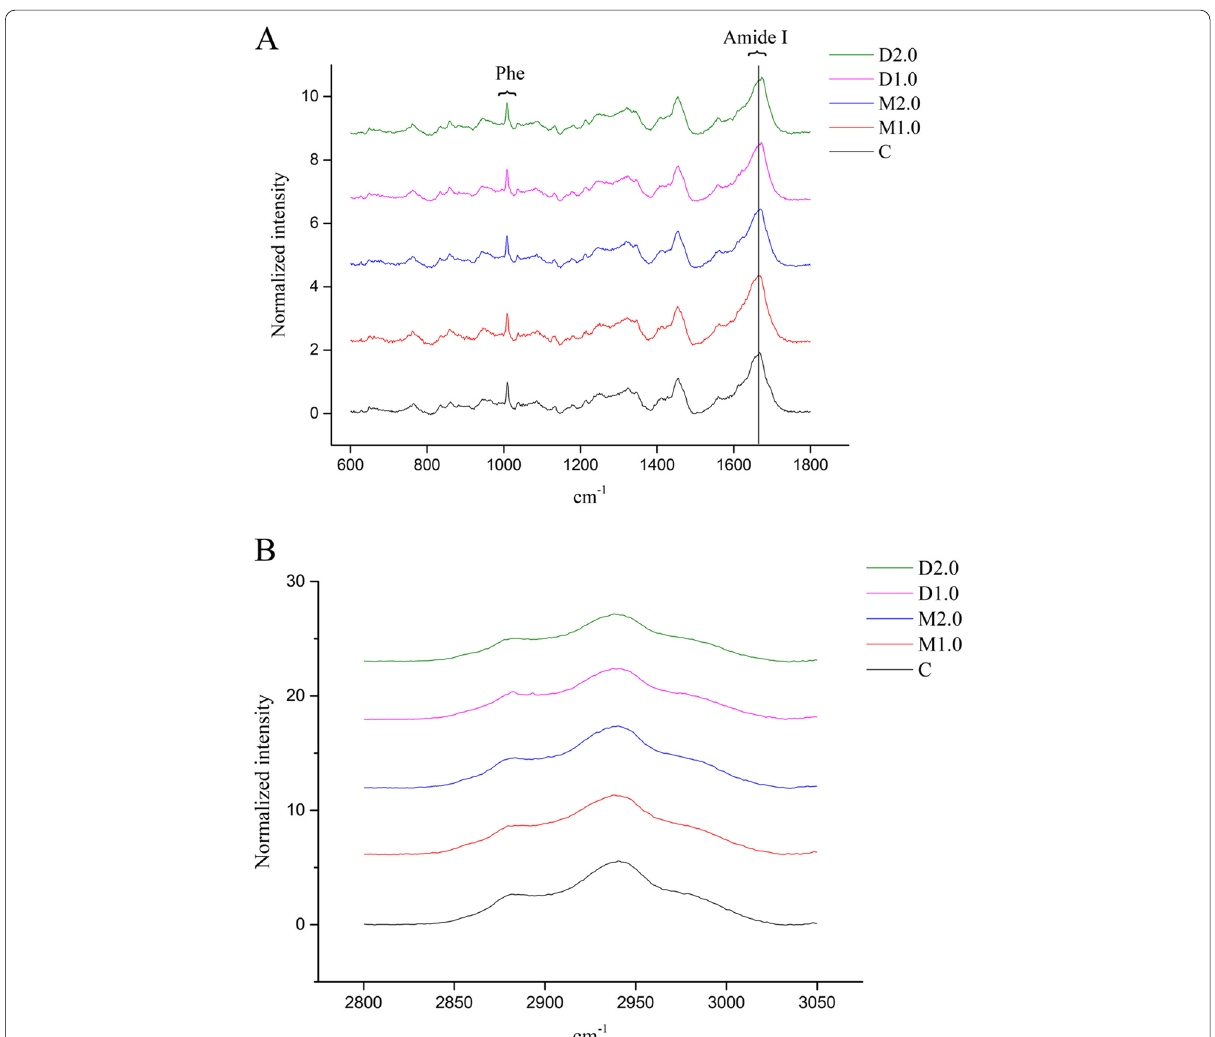
Fig. 5 Raman spectrum between 600 and 1800 cm − 1 of composite MP gels with modified starch and dietary fiber ( A ); Raman spectrum between 2800 and 3050 cm − 1 of composite MP gels with modified starch and dietary fiber ( B ). C: The control; D1.0: MP with 1.0% modified starch; D2.0: MP with 2.0% modified starch; M1.0: MP with 1.0% dietary fiber;; M2.0: MP with 2.0% dietary fiber Table 3 The frequency of characteristic peak in Admin I and normalized intensities of 2945 cm − 1 band of composite MP gels with modified starch and dietary fiber Treatments Admin I I2945/1003